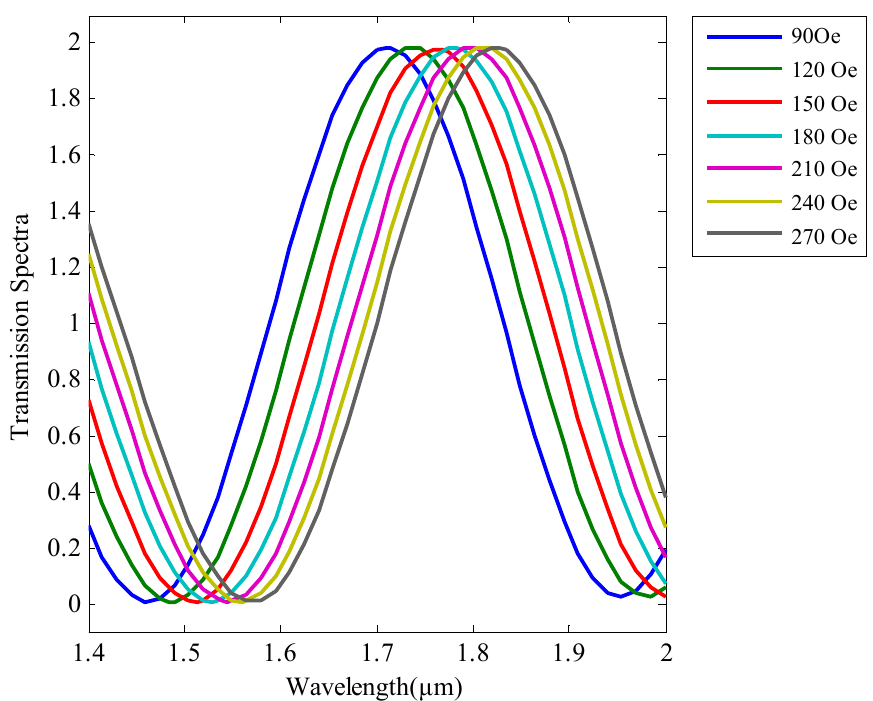
Figure 7. The total transmission spectra of dual-core PCF with different magnetic field strength. There are different transmission curves with different structure parameters. Figure 8a represents total transmission spectra when d changes and is solid curves when d = 0.84 μ m and dashed curves when d = 1.05 μ m. Figure 8b shows the transmission curves when the pitch ( Λ ) of the fiber changes. The transmission spectrum line is solid curves when Λ = 2.1 μ m and dashed curves when Λ = 2.3 μ m, because the increasing pitch causes the widening of the channel and the transmission curve shift. Figure 8c represents total trans- mission spectra when η c changes, which is solid curves when η c = 0.5 and dashed curves when η c = 0.6. Figure 8d shows the total transmission curve shift with η changing, and the